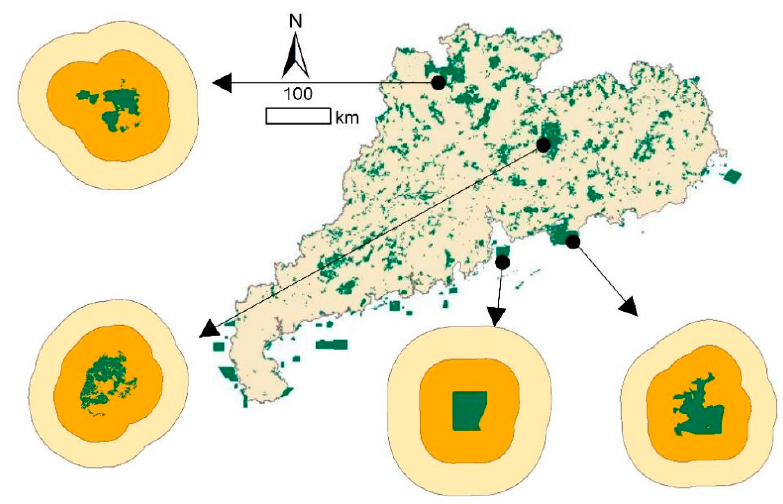
Figure 6. Light governance areas outside PAs. The inner orange zone is within 20 km, and the outer yellow zone is 20–40 km.